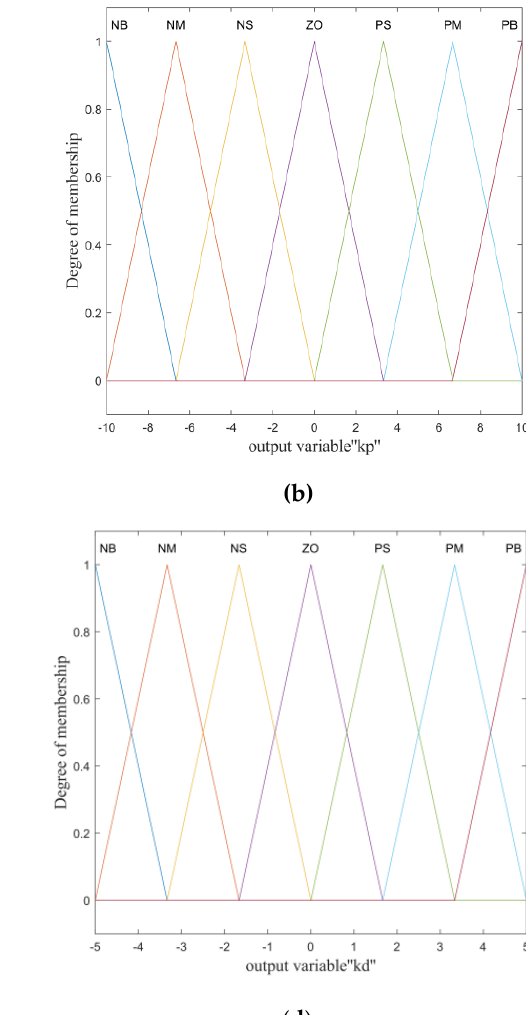
8 of 18 Figure 7. Fuzzy PID structure of control system. 4.4.2. Fuzzy PID Controller With the lateral deviation of the wheat no-till seeder as the control object, e and ec were used as the input variables of the fuzzy PID controller. The displacement of the pis- ton rod on the hydraulic cylinder was used as the output variable to design the fuzzy PID controller. We set the forward direction of the lateral shift mechanism as negative on the left and positive on the right, and set the fuzzification process to be described by seven linguistic variables, namely, NB (negative large), NM (negative middle), NS (negative small), ZO (zero), PS (positive small), PM (positive medium) and PB (positive large). For engineering implementation, the triangular affiliation function was used in practical ap-